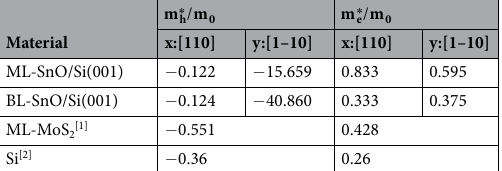
Table 1. Effective mass calculated for ML and BL SnO/Si(001) surface, along with the values of MoS 2 and Si for comparison. [1] Present calculation. [2] B. Van Zeghbroeck, Principles of Semiconductor